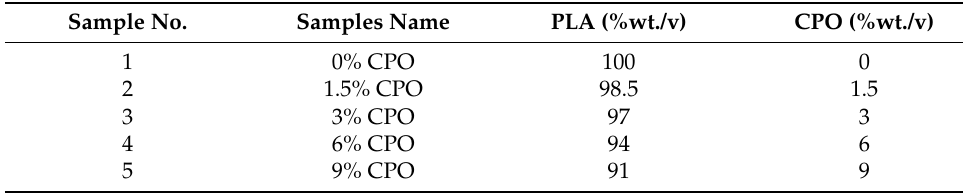
Figure 9. Schematic illustration of composite filament production. Table 1. PLA/CPO